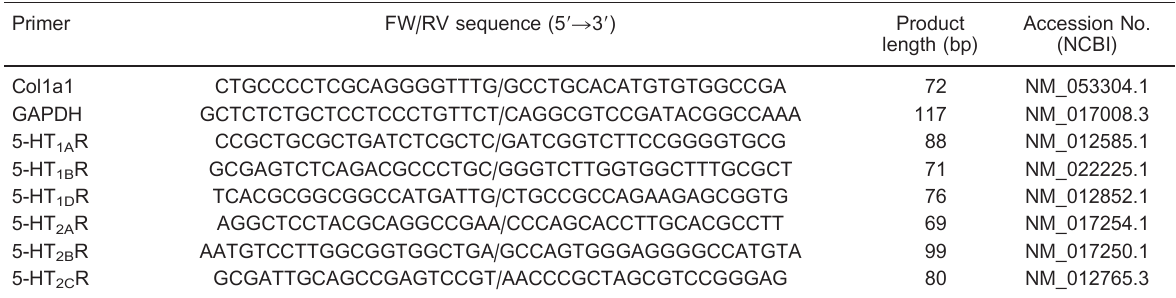
Table 1. Primer sets used in real-time RT-PCR. Primer FW/RV sequence (5 9 R 3 9 )